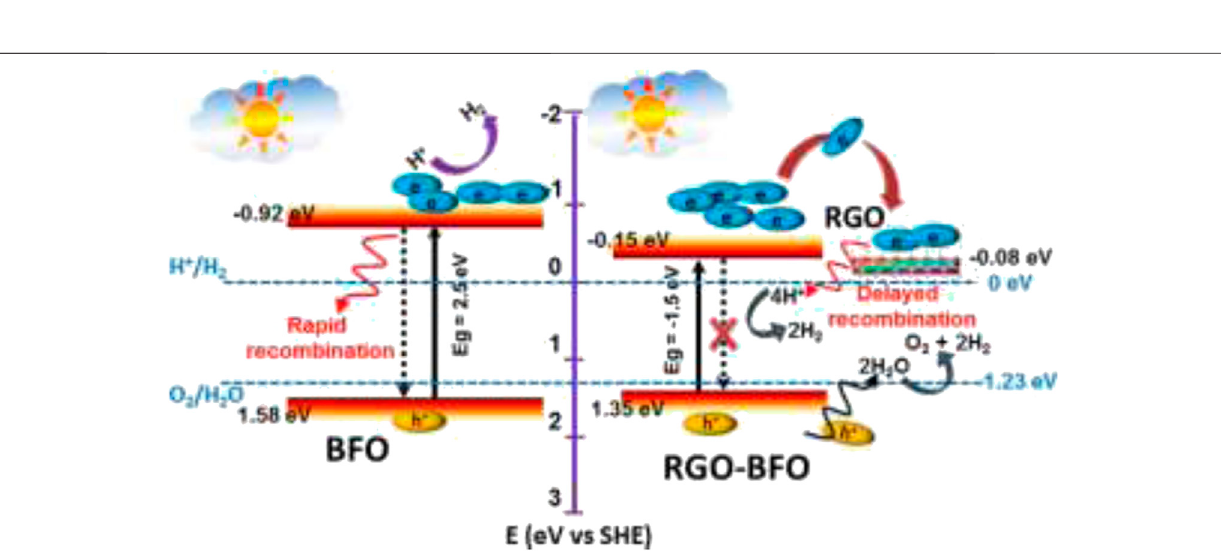
Frontiers in Chemistry |